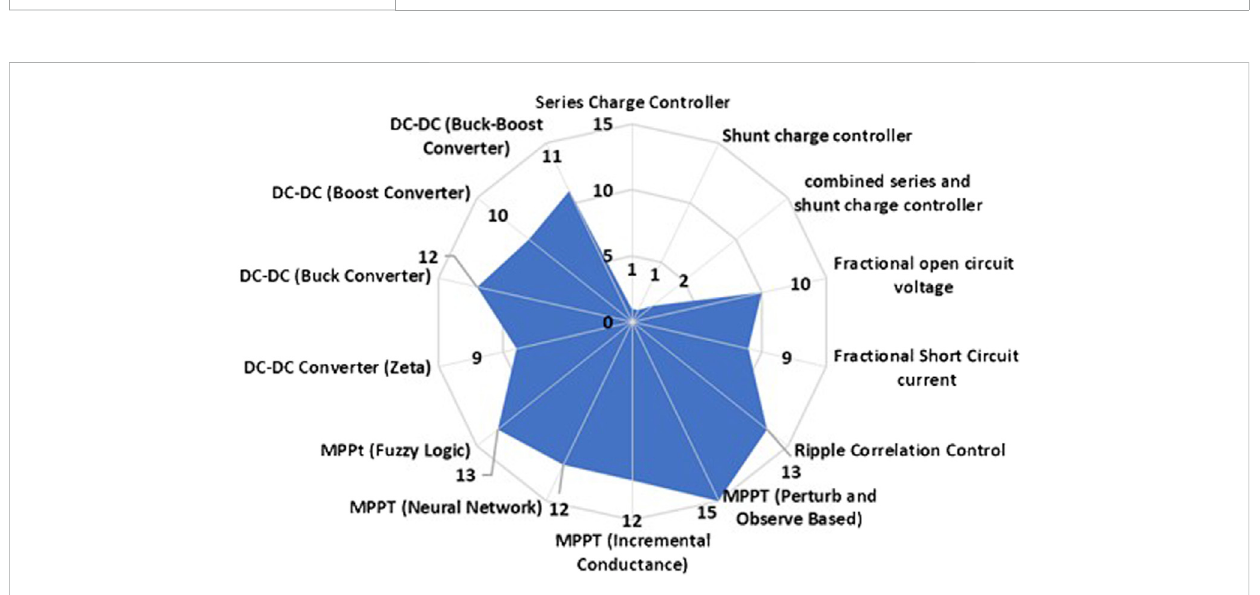
FIGURE 4 The core fi elds focused on by different research